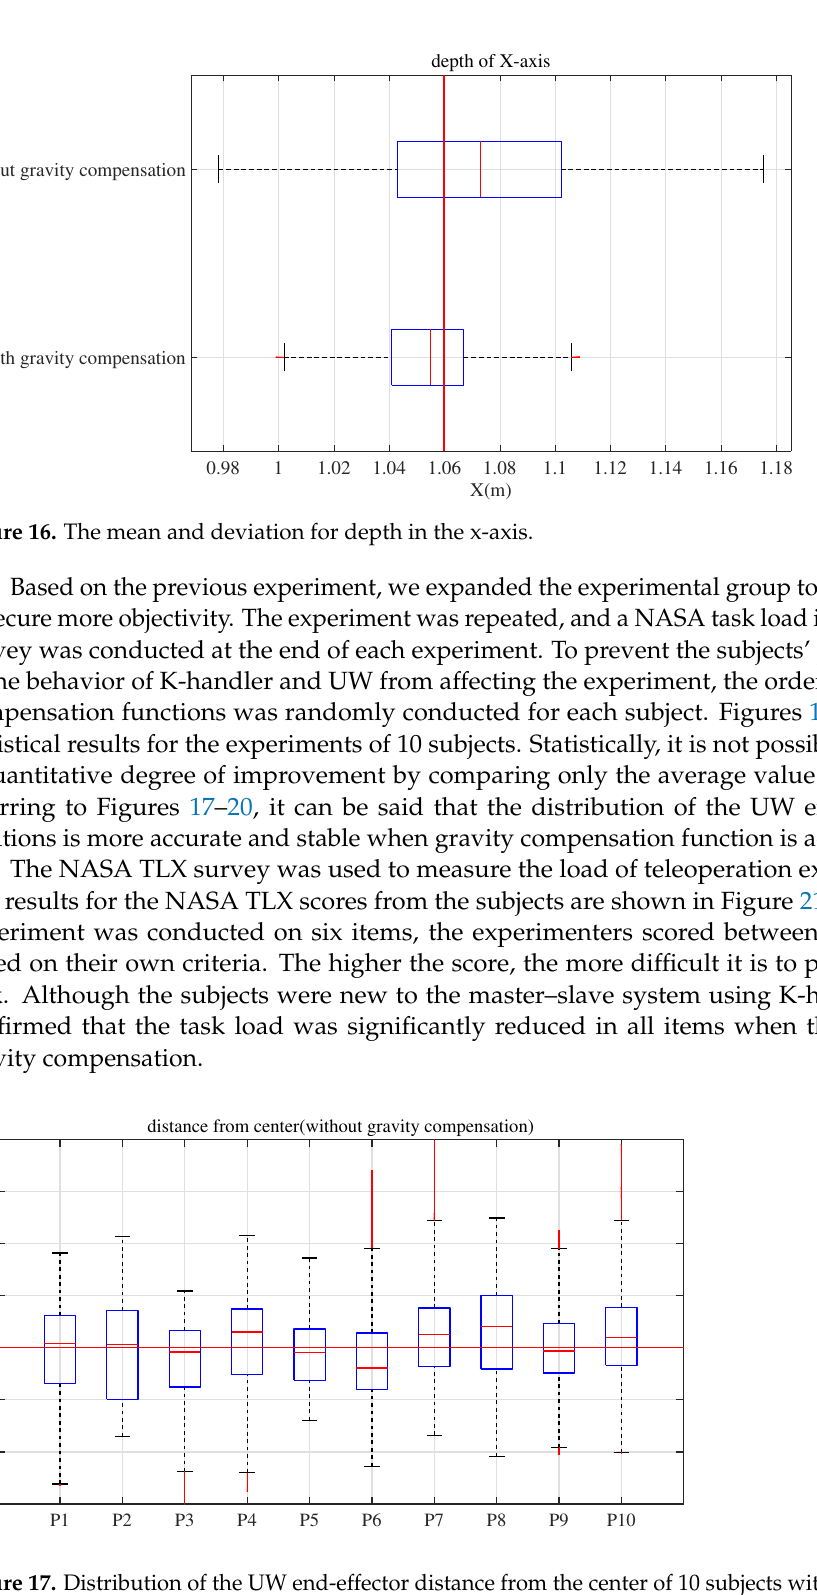
Figure 17. Distribution of the UW end-effector distance from the center of 10 subjects without gravity compensation of